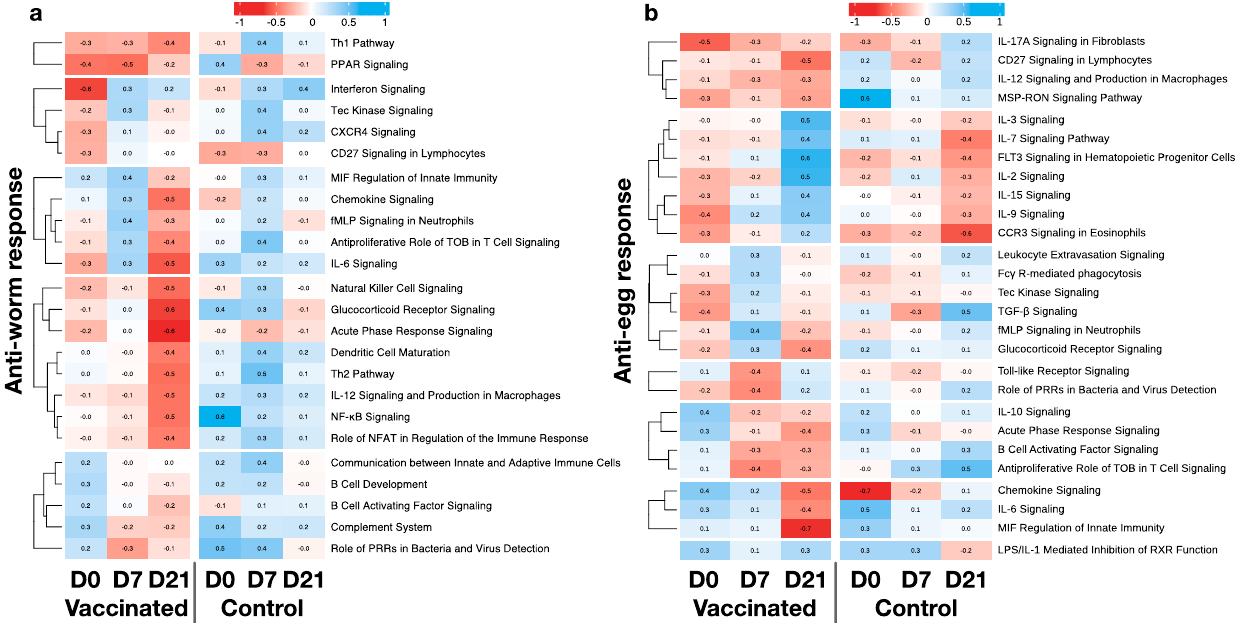
Fig. 3 Association between immune pathway gene expression and parasite infection post vaccination. Heat map of correlation coef fi cients between ( a ), worm burdens or ( b ), cFEC and gene expression in the selected pathways before challenge (D0), seven (D7) and 21 (D21) days post challenge in vaccinated and control lambs. Colours represent negative (red) and positive (blue) Pearson correlation coef fi cients for each comparison. The immune pathways were clustered using k-means according to their correlation patterns over time in the vaccinated